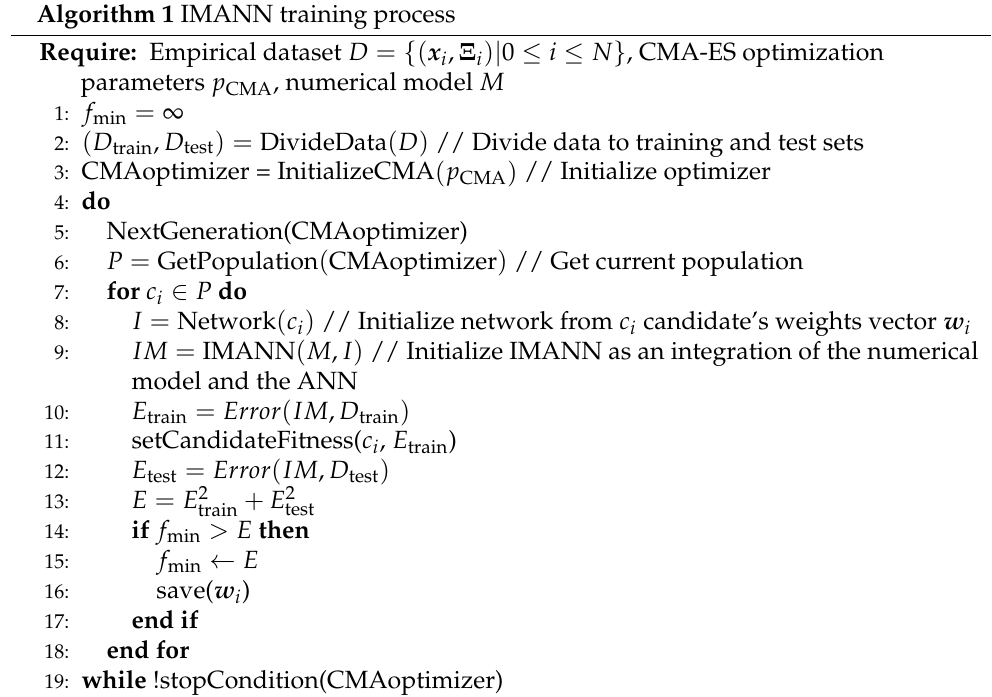
Algorithm 1 IMANN training